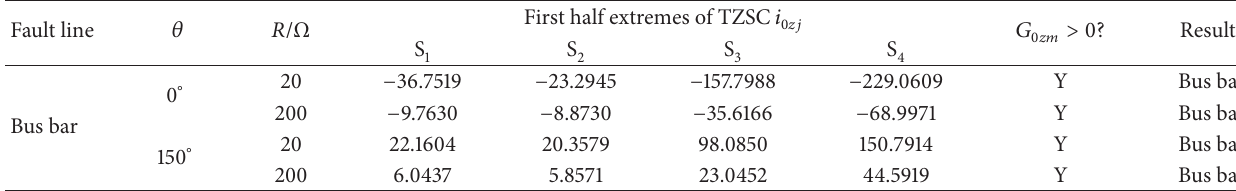
Table 5: SK relative energy entropy with S